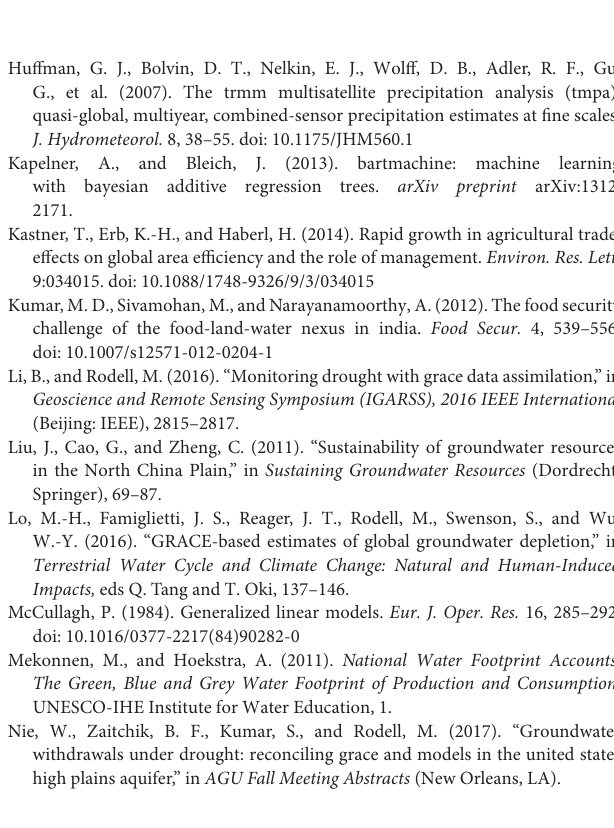
Table A1 | Complete list and data sources of country level indicators used as inputs to BART